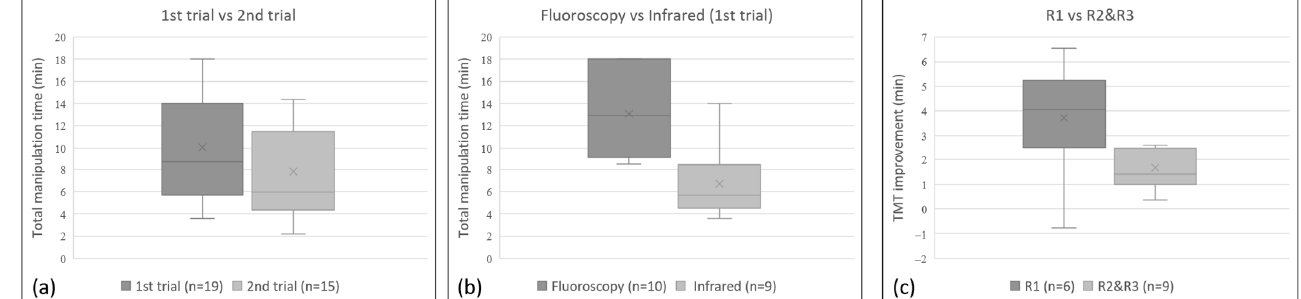
Figure 6. Statistically significant differences ( p < 0.05) can be observed in the box plot of ( a ) the TMT of the first trial vs. that of second trial for all participants—showing that the TMT of the second trial was significantly shorter than that of first trial—( b ) the TMT of the first trial using fluoroscopy versus the infrared system—showing a significantly shorter TMT using the infrared system than that using the fluoroscopy—and ( c ) the TMT improvement of junior participants (R1) versus senior participants (R2 and R3)—showing a significantly larger improvement in the TMT of the junior participants (R1) than that of senior participants (R2 and R3).